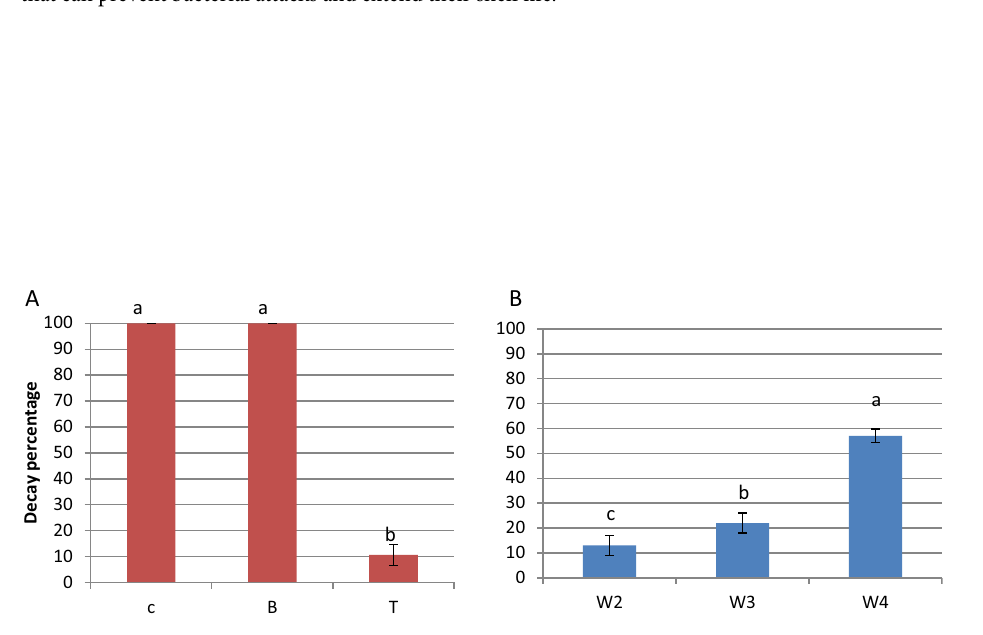
Figure 7. Decay percentage of different cheese treatments. ( a ) Decay (%) of different cheese samples on the second week of storage. ( b ) Decay (%) of T samples during the storage period. Data are the means ± S.E. (n = 15). Different letters indicate significant differences (p <